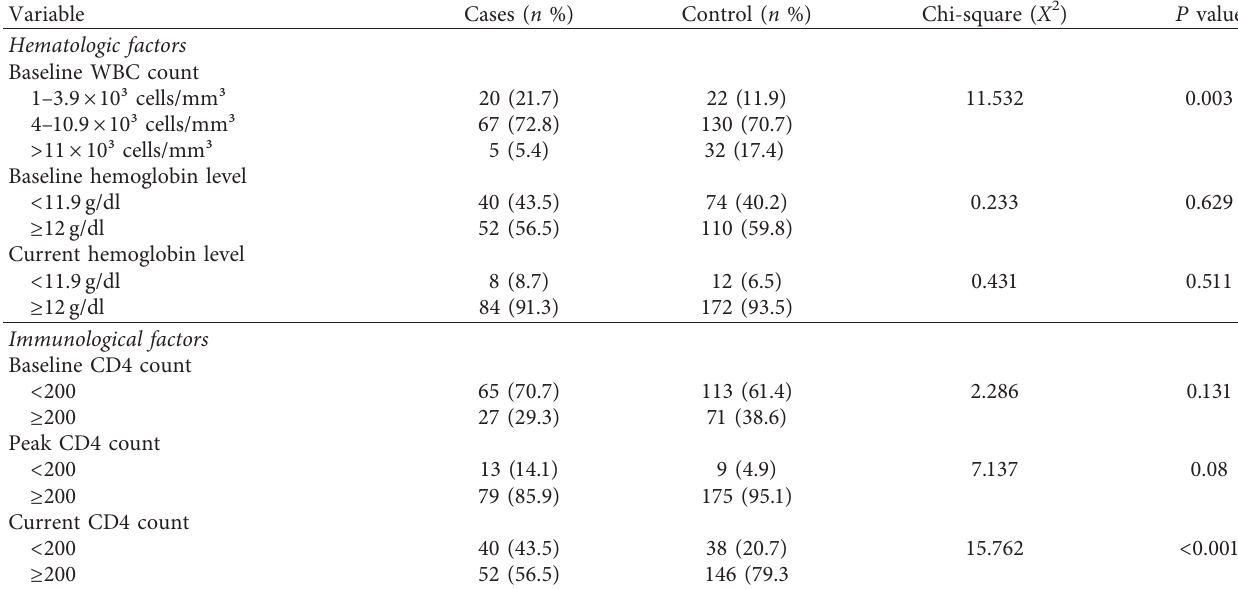
Table 2: Hematologic and immunological findings on ART clients at Waghimra zone health institution ARTclinic, Northern Ethiopia, in 2019 ( n �